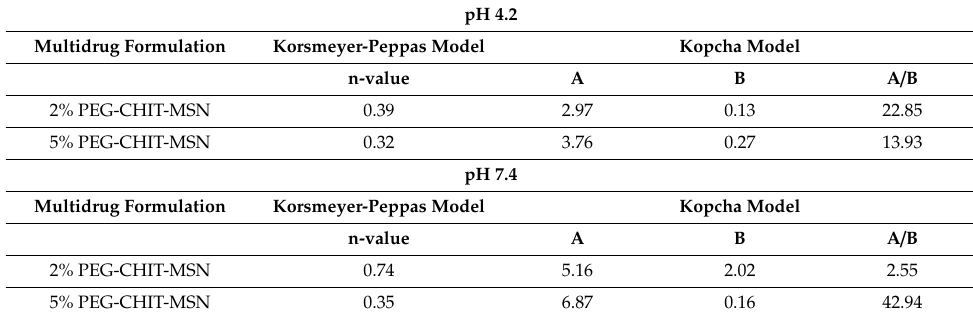
Table 6. Korsmeyer-Peppas model’s release exponent factor and the corresponding Kopcha’s release model fitting